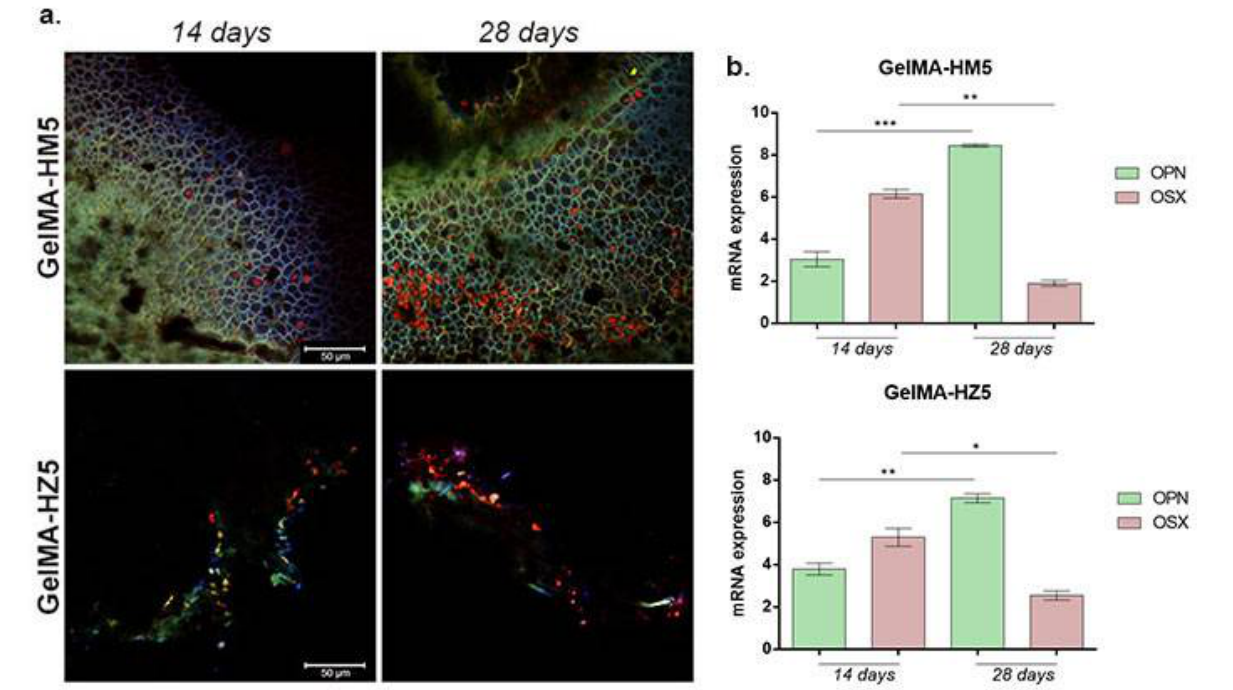
Figure 18. ( a ) Protein expression of osteogenic markers (OPN and OSX) after 14 and 28 days of osteogenic differentiation visualized by immunofluorescent staining in contact with GelMA-HM5 and GelMA-HZ5 composites. Murine preosteoblasts were highlighted using immunofluorescence, showing the composite of cell nuclei in blue, OPN in green, and OSX in red. Scale bar size is 50 µ m. ( b ) Gene expression of OPN and OSX during 28 days of osteogenesis in the presence of GelMA-HM5 and GelMA-HZ5 scaffolds. Statistical significance: * p < 0.05, ** p < 0.01, *** p < 0.001.